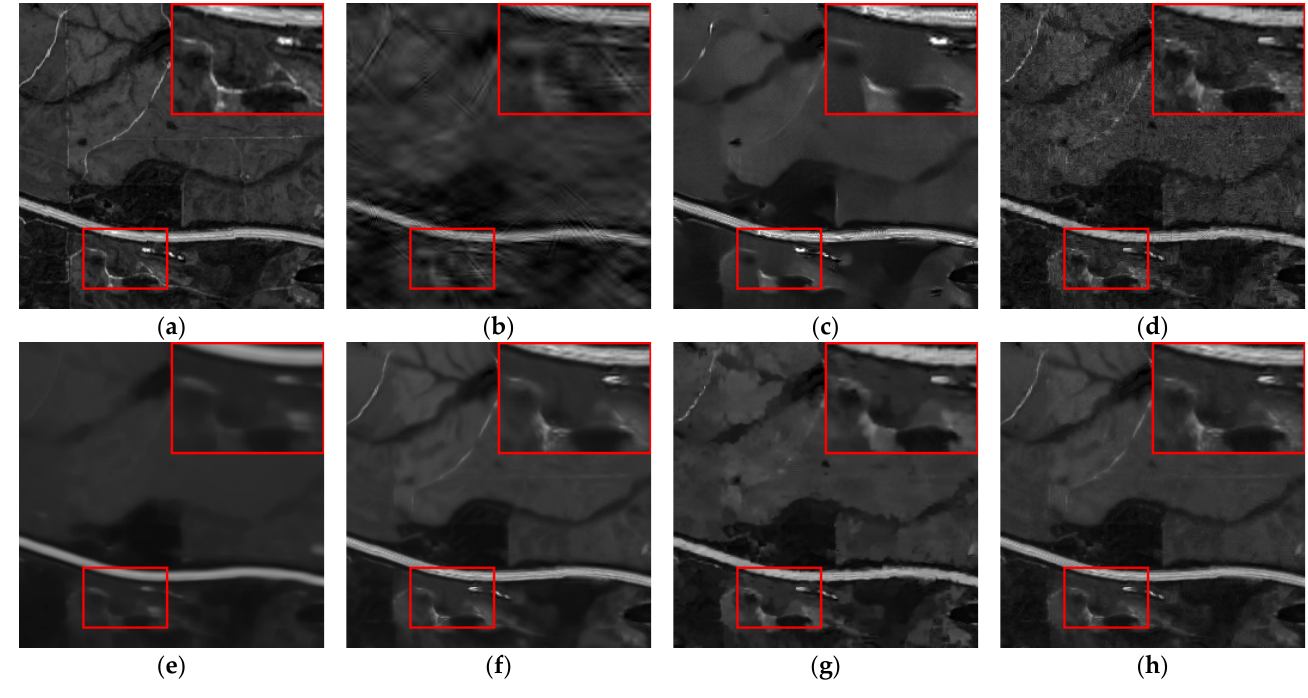
Figure 10. The corresponding ratio images for S1. ( a ) W-C; ( b ) PPB; ( c ) SAR-BM3D; ( d ) H-WNNM; ( e ) GNLM; ( f ) FANS; ( g ) Proposed method.